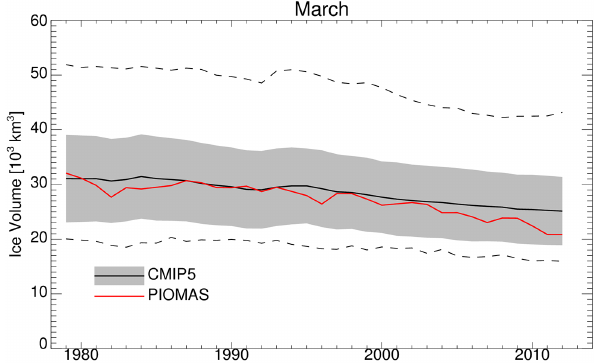
Figure 7. Change in Arctic sea ice volume as shown in the CMIP5 ensemble and in PIOMAS for the period of 1979 to 2012, for March. Gray shading shows the ± 1 standard deviation of CMIP5 ensemble. Upper and lower dashed lines show maximum and min- imum ice volume of the model ensemble. Multimodel ensemble mean ice volume is shown as the black line.